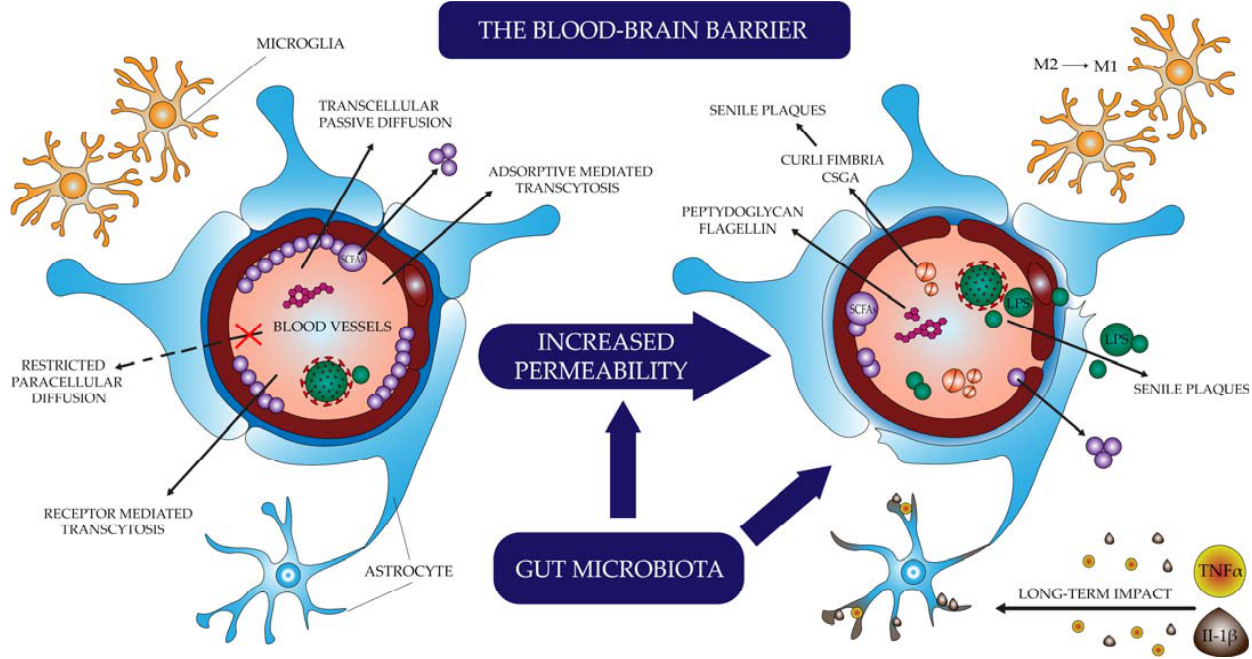
Figure 1. The process of neuroinflammation.